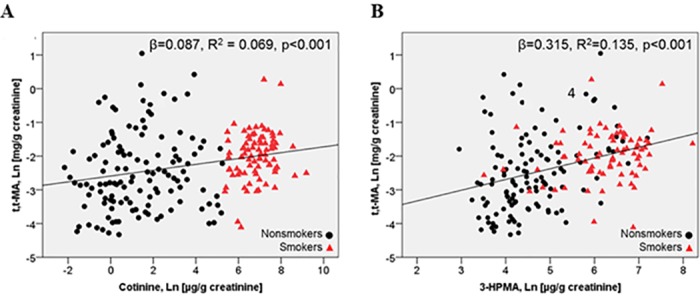
Association between cigarette smoke exposure and t,t-MA levels.Associations of t,t-MA with cotinine (A) and 3-HPMA (B) were established by regression analysis. Cigarette smoke is the major source of benzene exposure in the smoking sub-group.